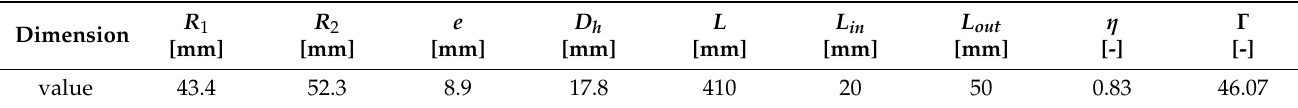
Figure 6. Air gap (solid) and outside volume (transparent) geometry as used in the basic numerical model of flow with wavy Taylor vortices. The applied boundary conditions are also depicted. Table 1. Dimensions and geometrical parameters of the air gap in which wavy Taylor vortices are observed.